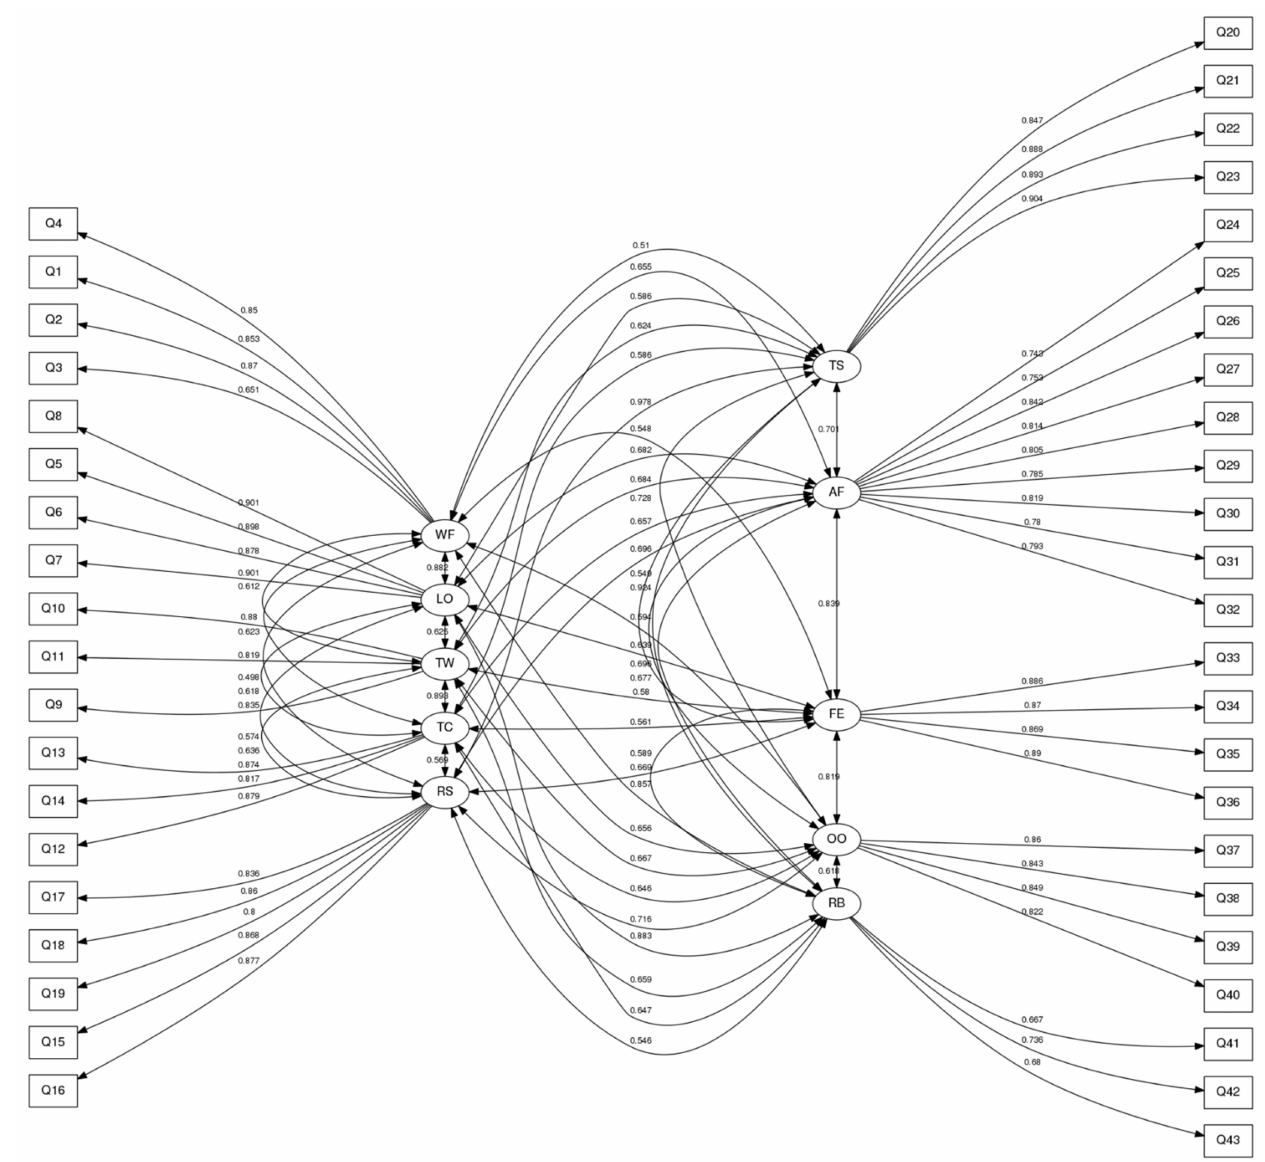
Figure A1. Standardized coefficients for the 10-factor model for OEQ based on CFA through the software package sem 3.1-9 for R 3.4.1. χ 2 /Df = 15.607 ( p < 0.001), GFI = 0.924, AGFI = 0.912, CFI = 0.964, NFI = 0.962, IFI = 0.964, and RMSEA =